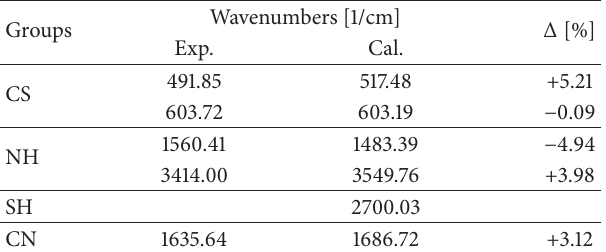
Table 4: The comparison of experimental (in Figure 5) and the- oretical (in Figure 3(c)) frequencies of PSTM-3T after treatment by hydrochloric acid (pH = 2) solution. The percentage of relative deviation of model in different frequencies is shown in